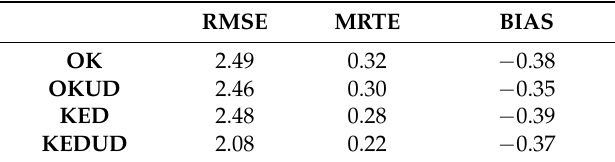
Table 3. Deterministic validation results for the four tested rainfall products, in terms of RMSE, MRTE and bias. RMSE MRTE RMSE MRTE BIAS OK 2.49